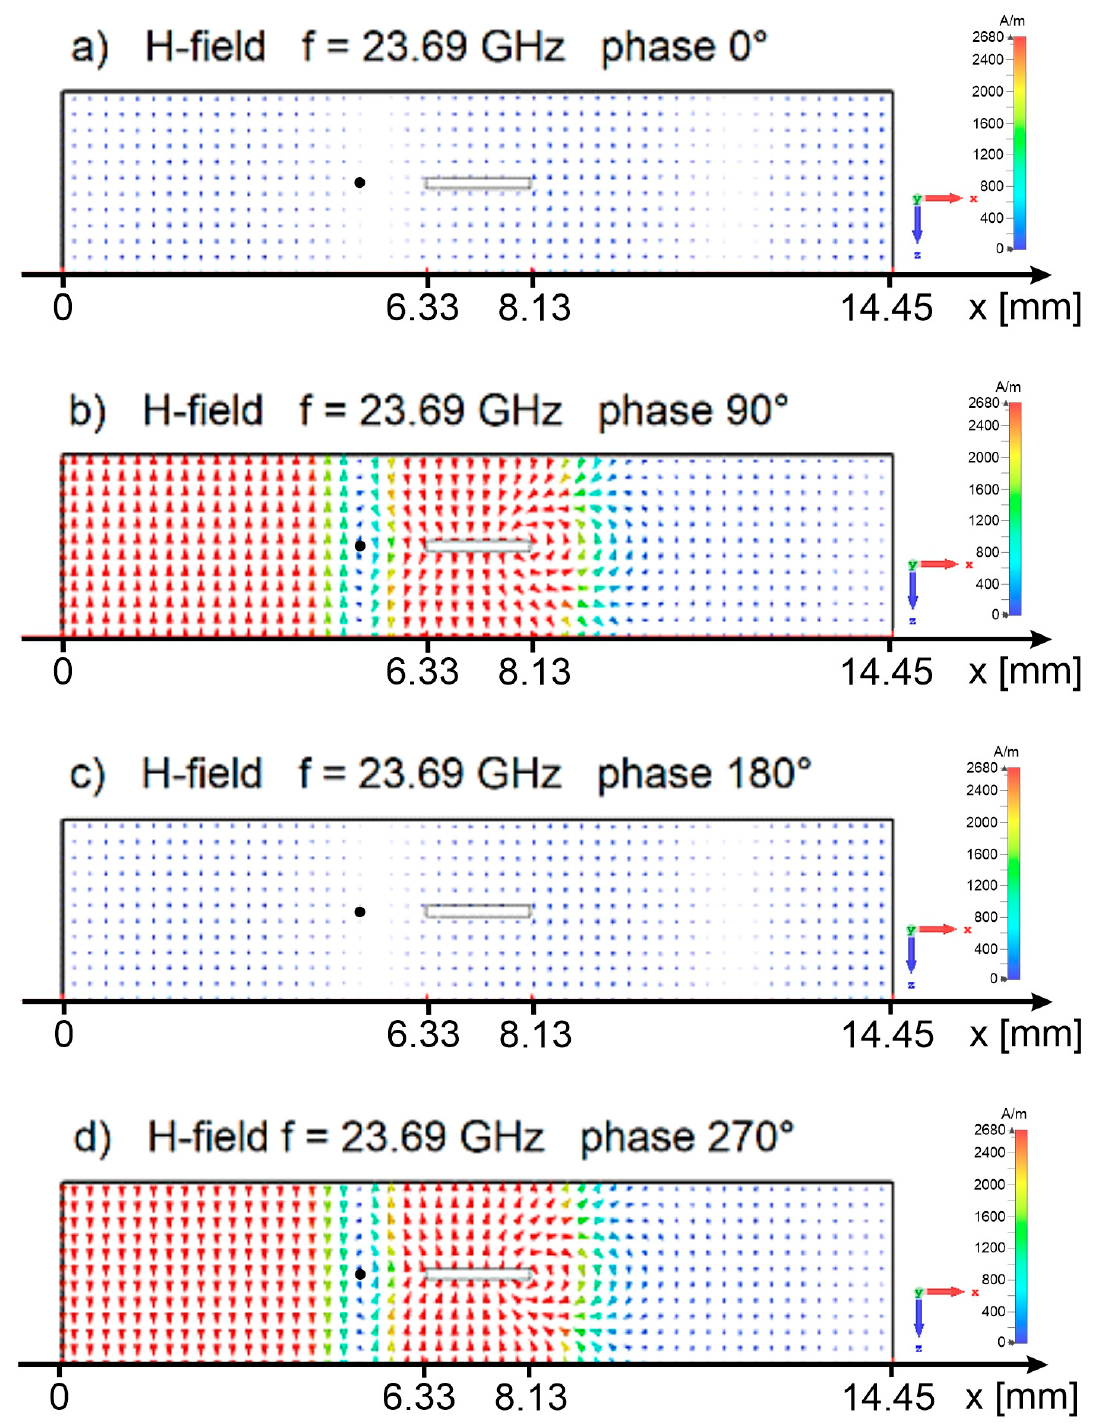
Figure 7. Distribution of the magnetic field H in the cross-sections xz for y = 1.9 mm at f = 23.69 GHz corresponding to the magnetic resonance. The plane electromagnetic wave propagates in the +x axis: ( a ) Phase 0°; ( b ) phase 90°; ( c ) phase 180°; ( d ) phase 270°. Black points, the nodes of the standing wave.